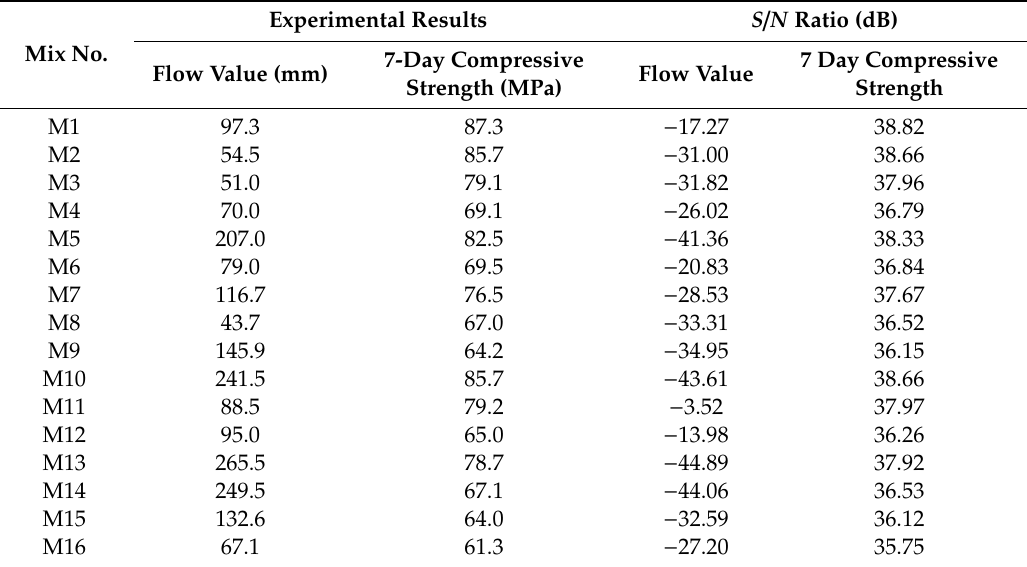
Table 9. Experimental results and signal-to-noise ( S / N ) ratios of the matrixes.